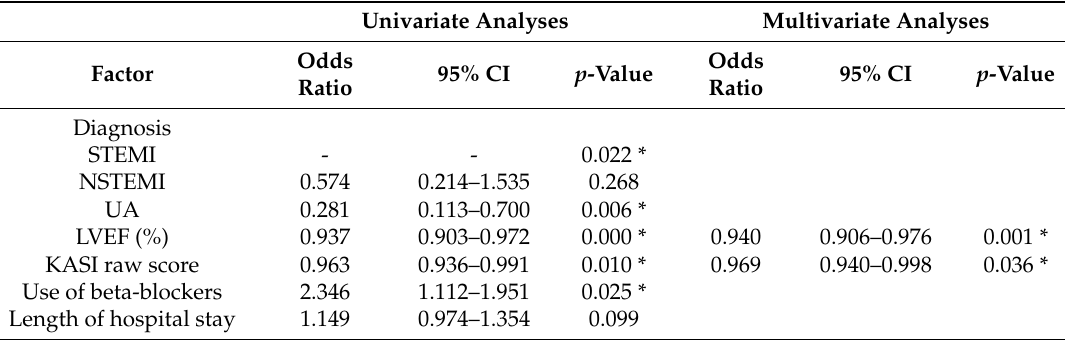
Table 5. Causational factors of anxious mood in patients with CAD. Univariate Analyses Multivariate